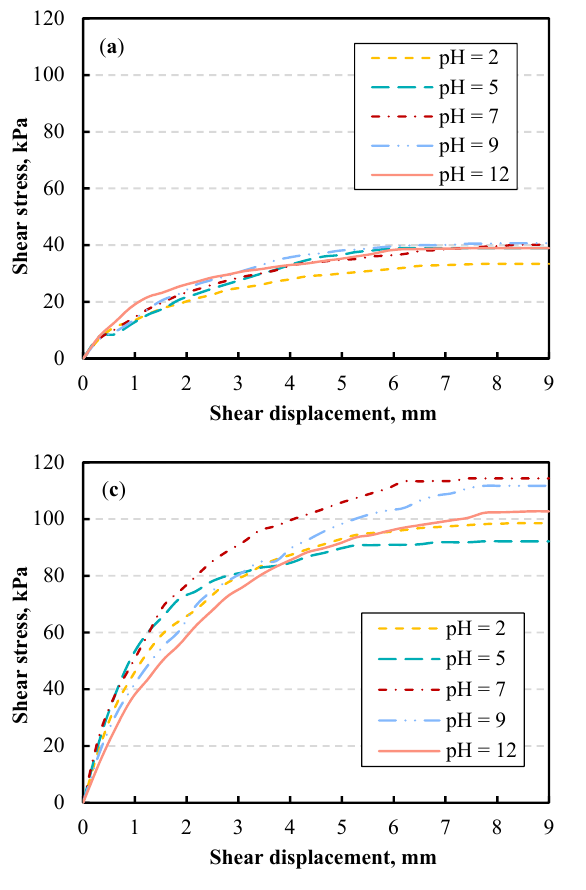
Figure 6. Relationship between shear stress and shear displacement of the acid- and alkali-contaminated soils under overburden stresses of ( a ) 50 kPa; ( b ) 100 kPa; ( c ) 150 kPa.